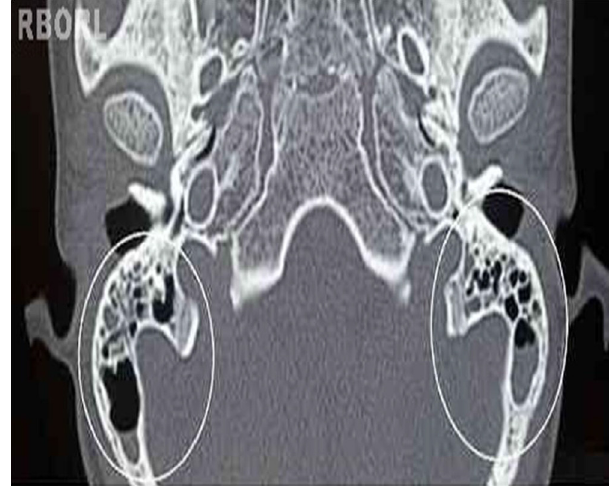
Figure 1 Mastoid computed tomography, cross-sectional view. Within the clear circles, a bilateral partial clouding of mastoid cells is